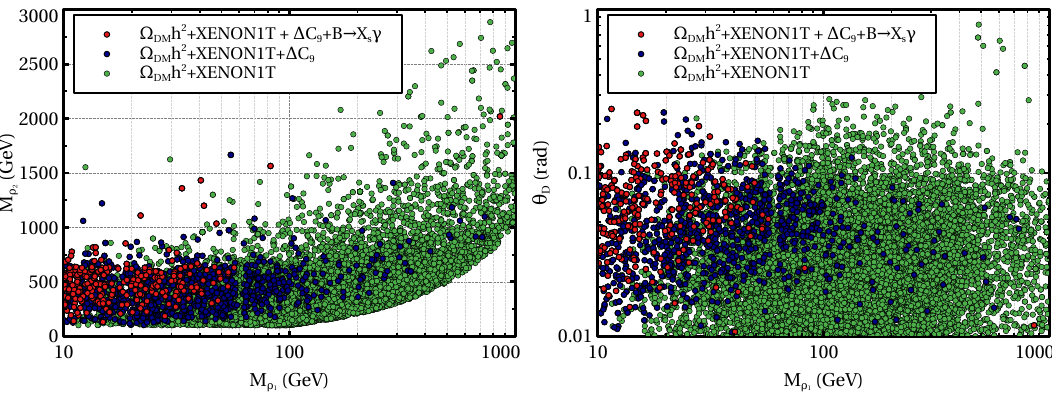
Figure 10 . Left(Right) panel: allowed region in M (cid:26) mental results considered in this